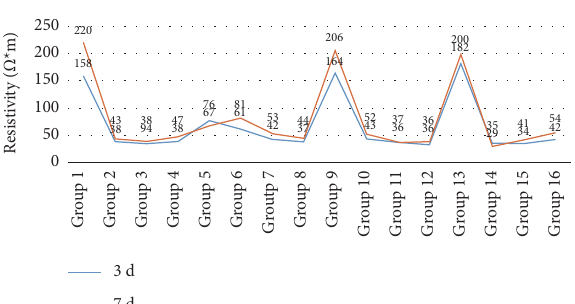
Figure 13: Change trends of the resistivity.